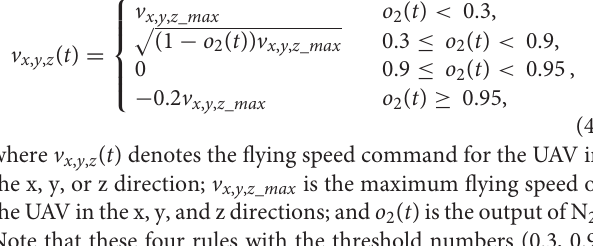
Figure 4A , the key components comprise the following: (1) Pixhawk 2.1 (an open-source flight controller) and its accessories, including telemetry for data exchange with a ground station and receiver for obtaining manual control signals from a remote controller; (2) a compact optical distance measurement sensor (LiDAR-Lite V3) for obstacle detection; (3) an onboard computer (Odroid XU4) for implementing the proactive neural controller ( Figure 3 ) and communicating with Pixhawk, Arduino, and the indoor localization system (OptiTrack); and 4) the Arduino NANO microcontroller, serving as buffer hardware for the interface between the sensor and onboard computer.